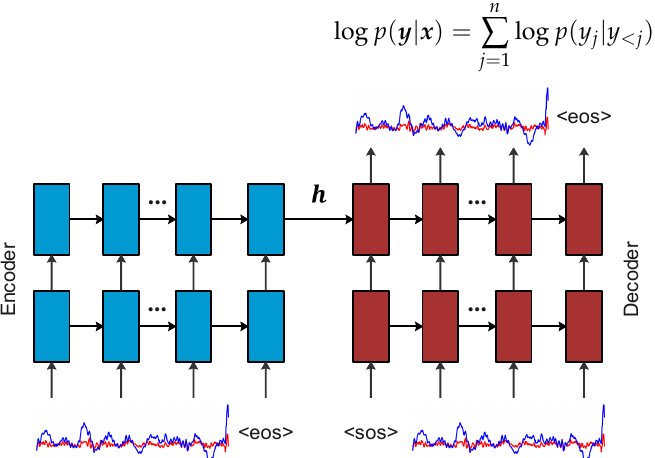
Figure 2. Seq2Seq model—a stacking recurrent architecture for reconstructing segmented signals. Here, <sos> marks the start of a signal; and <eos> marks the end of a